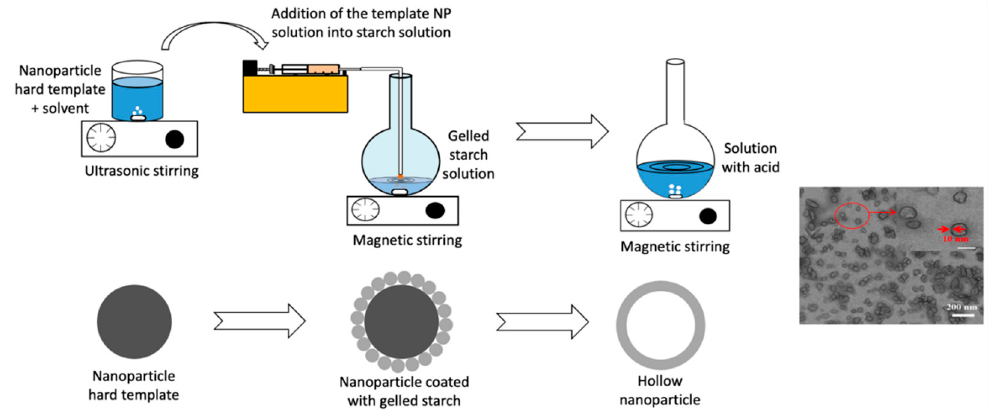
Figure 6. Synthesis of SNPs through sacrificial template method and TEM micrograph of pea, mung, bean, potato, and corn hollow SNPs [48].